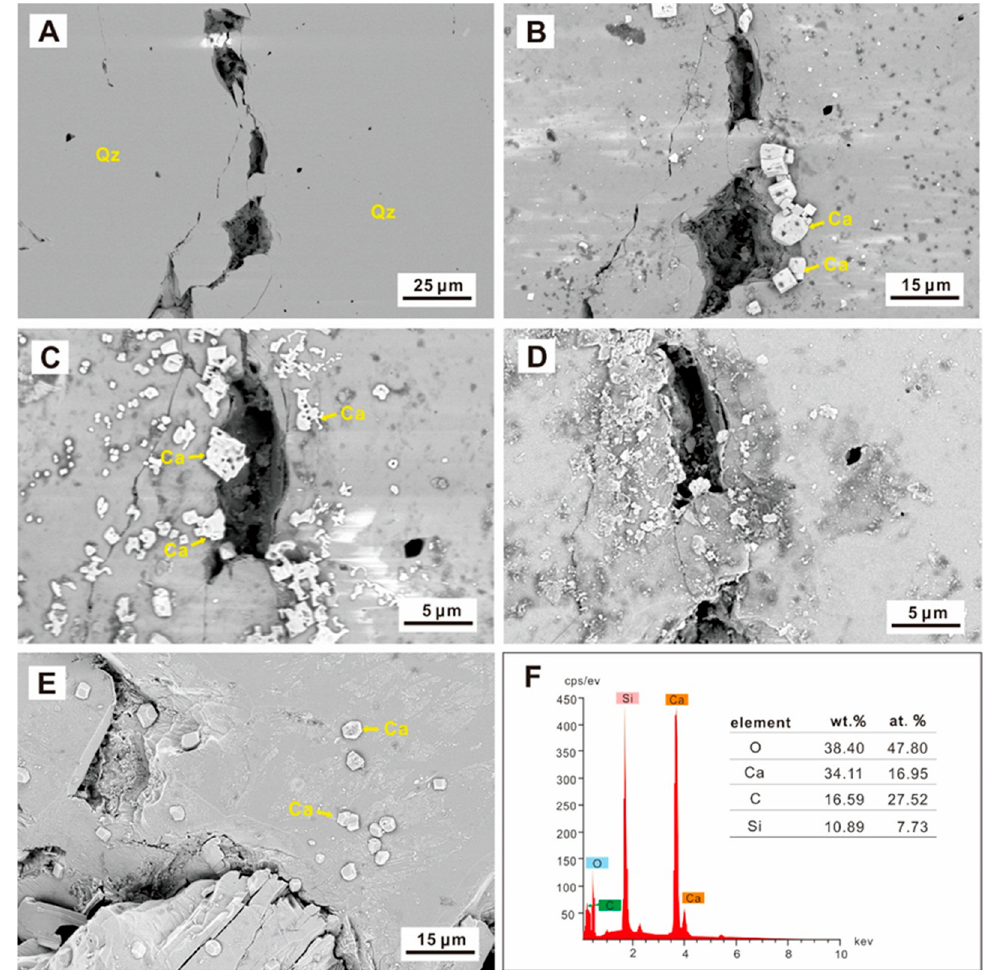
Figure 7. SEM images of calcite precipitation (Qz—quartz, Ca—calcite). ( A ) The initial sample; ( B ) Newly formed calcite on the sample’s surface after 24 h; ( C ) The newly formed calcite was dissolved after 72 h; ( D ) The sample at the end of the 432 h; ( E ) Calcite was found in other locations at the end of the 432 h; ( F ) The EDS analysis verified the calcite in ( B ).